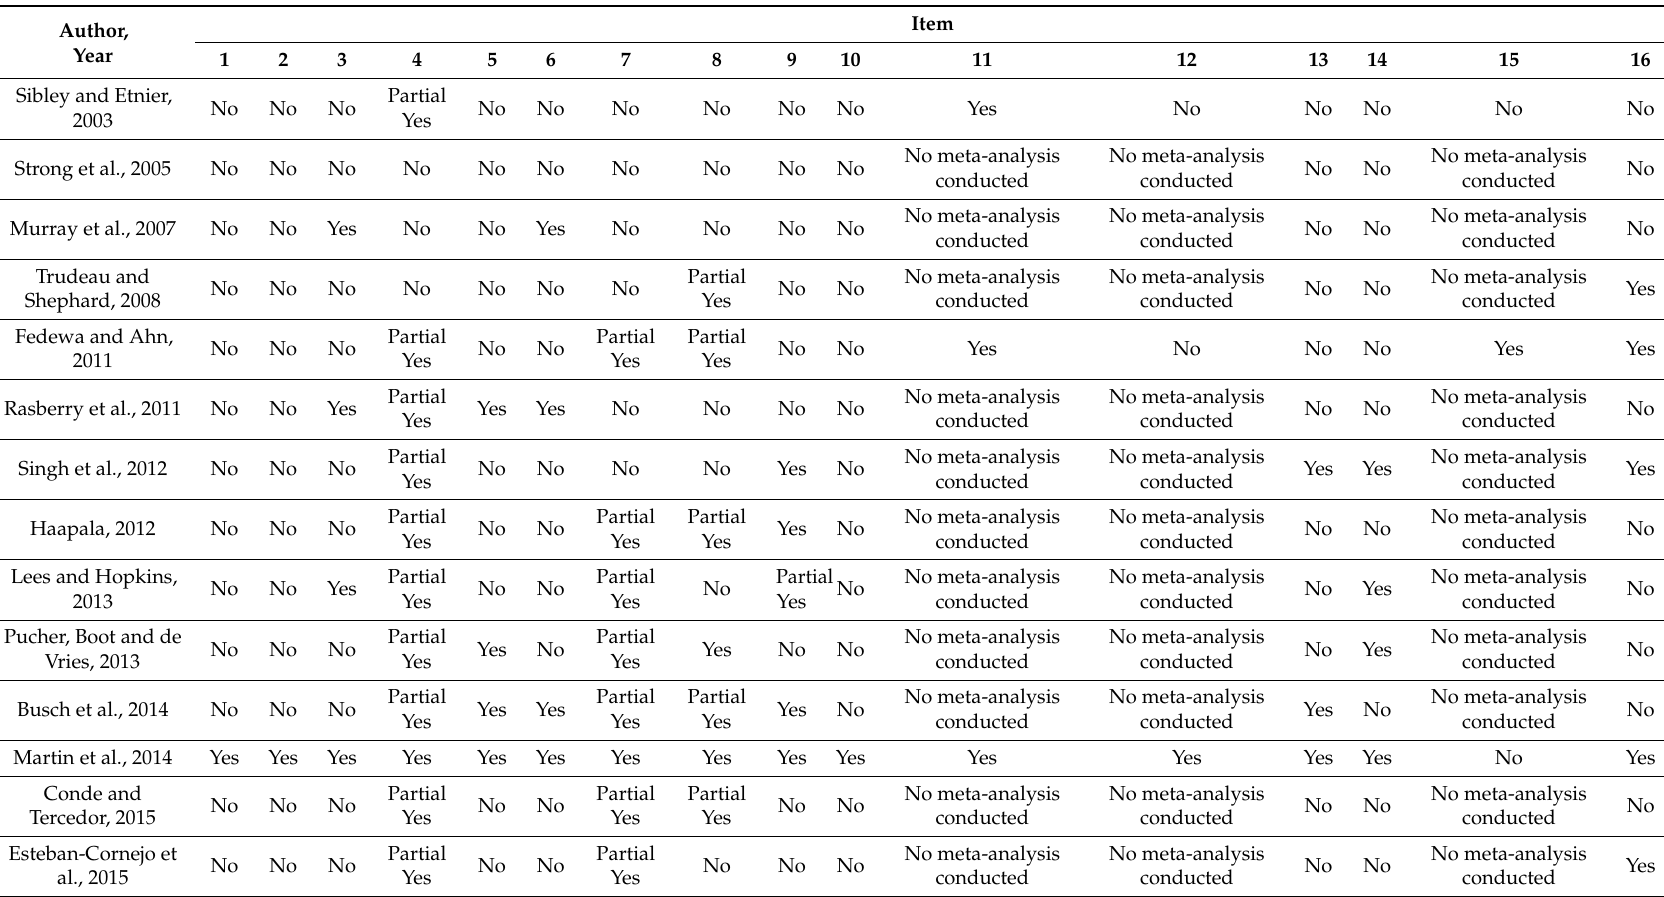
Table A1. Assessment of the methodological quality using AMSTAR 2